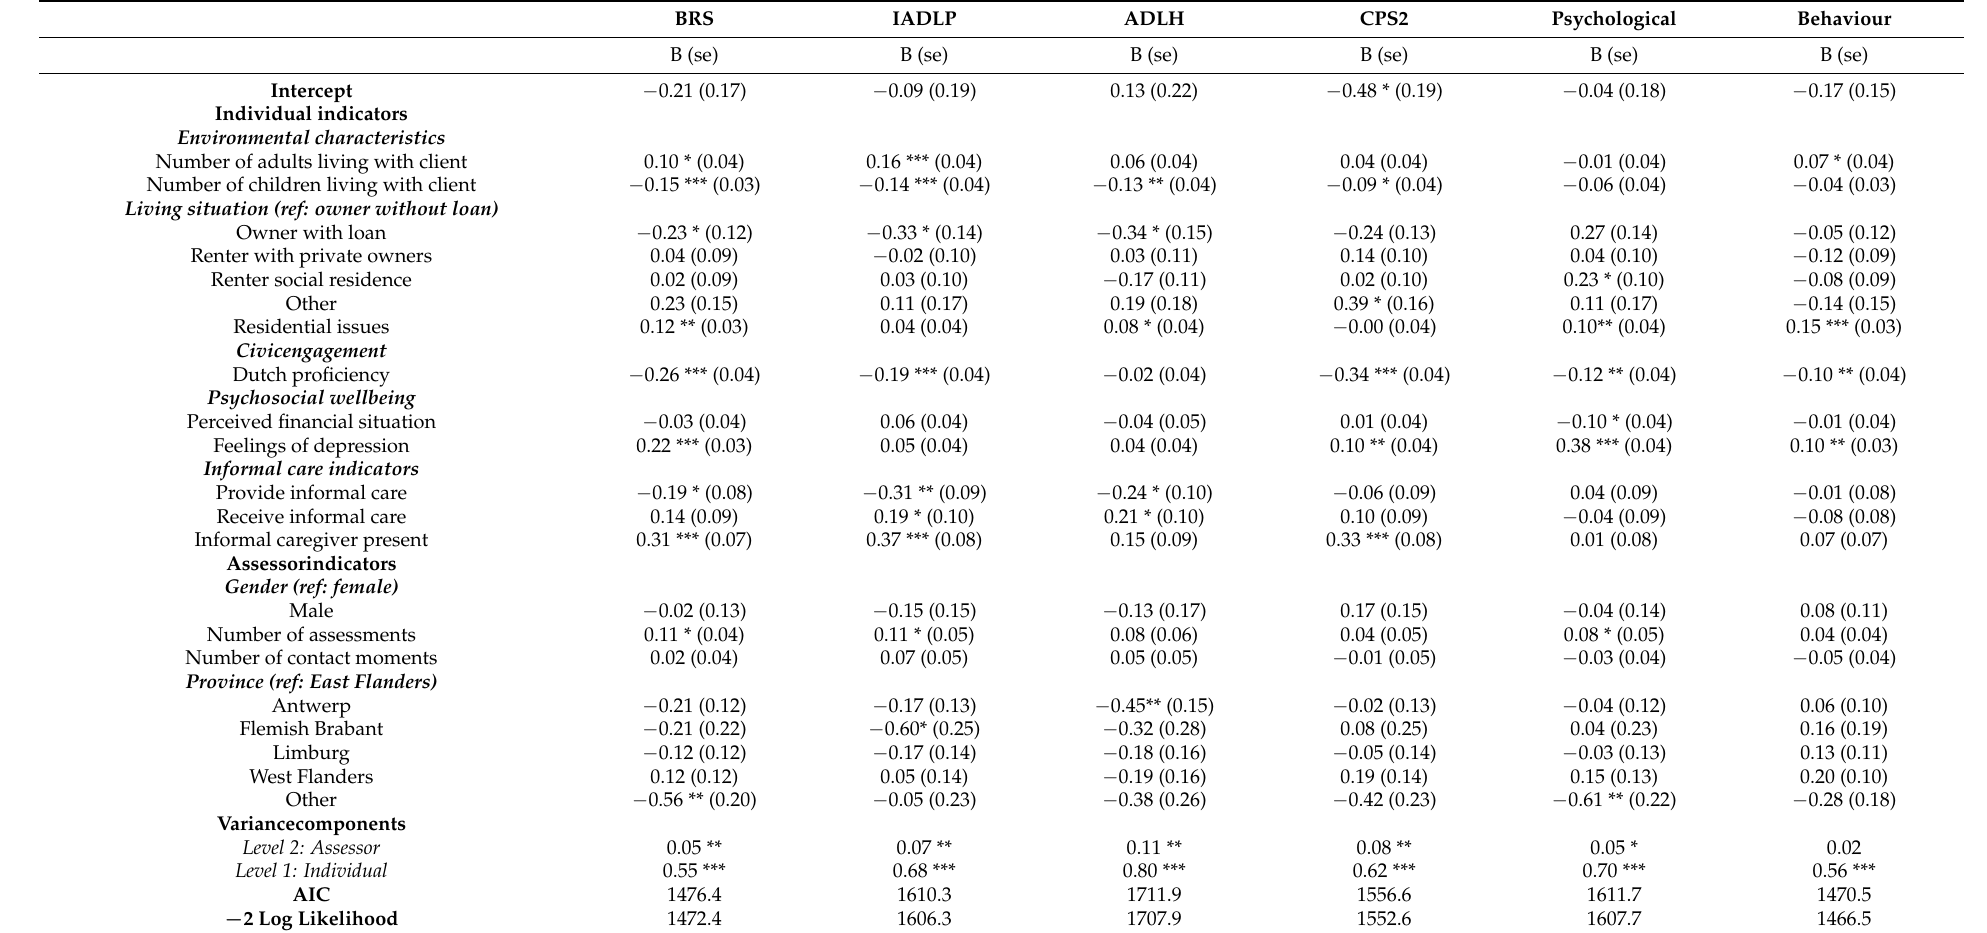
Table 4. Multilevel regression analyses of client- and assessor-level variables on assessment